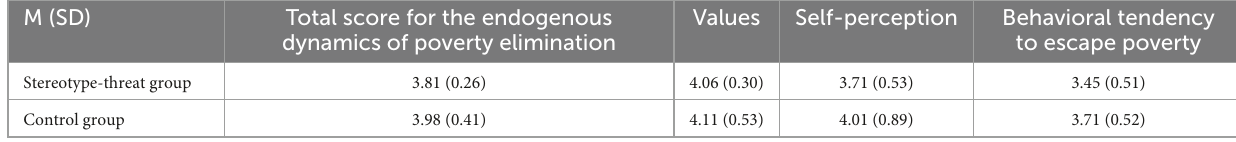
TABLE 5 Endogenous dynamics scale for the poverty-elimination scores of both groups. M (SD) Total score for the endogenous dynamics of poverty